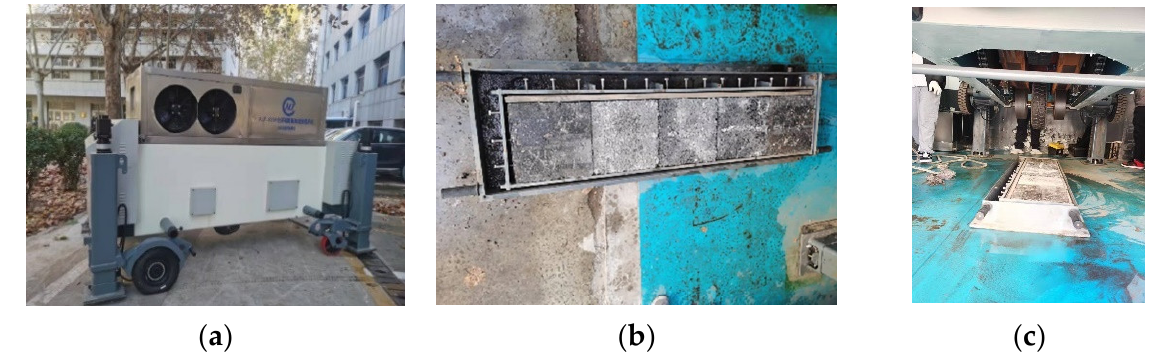
Figure 4. Experimental equipment and test conditions. ( a ) Test device. ( b ) Layout of specimens. ( c ) Loading test process.